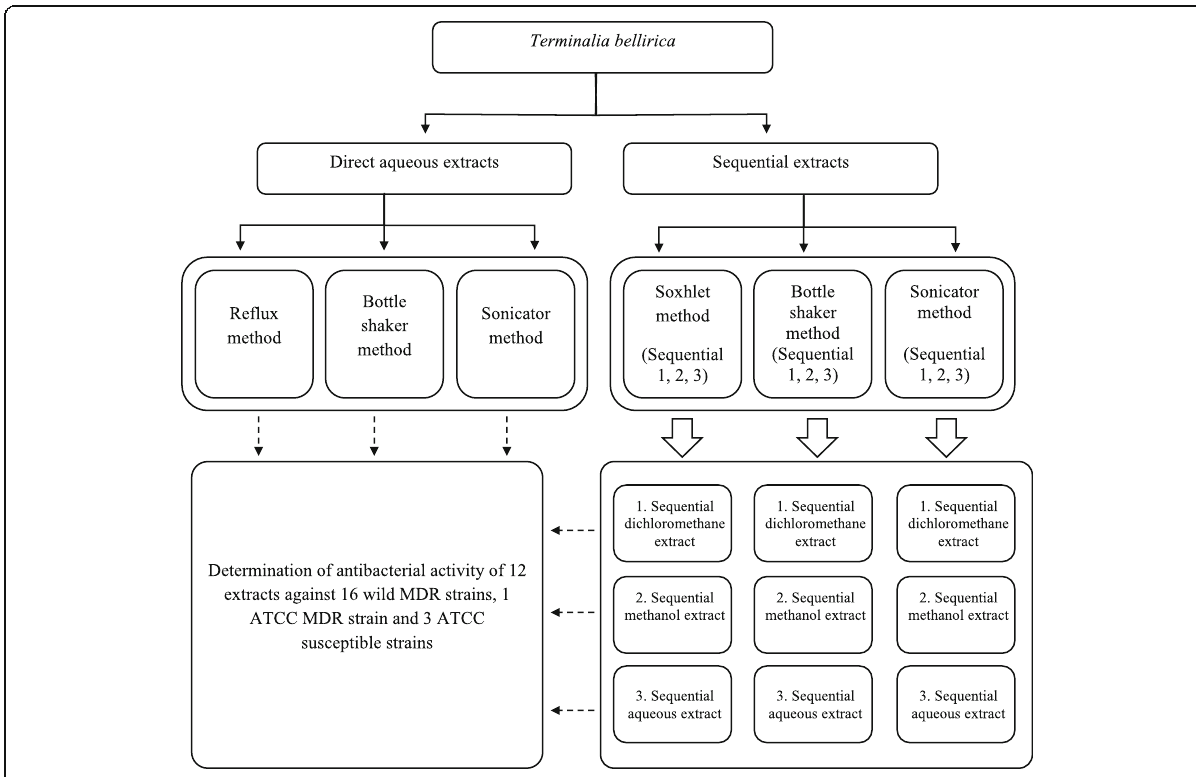
Fig. 1 An overview of different methods used for extracting dried pericarp of Terminalia bellirica